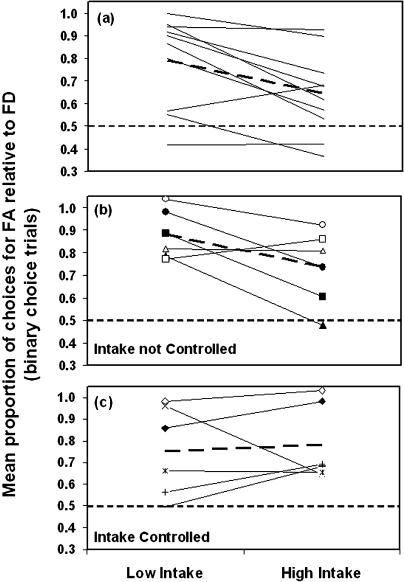
Individual Proportion of Choices for FA Relative to FD in Treatments “High Intake” and “Low Intake”(A) Effect of intake on choices without decoys. Here, extra food simulates the intake consequences that the two decoys cause when they are present and consumed on 25% of the feeding opportunities (p < 0.01).(B) Results of an experiment with decoys when energetic consequences of the decoys were allowed to take effect (group NC) (p = 0.06).(C) Results of an experiment with decoys, similar to (B), in which the energetic consequences of the decoys were abolished (group C).In (B) and (C), each symbol corresponds to each of the subjects. The dashed lines show the mean values in each of the cases.